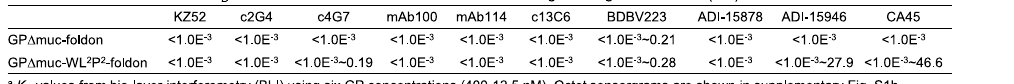
Fig. 2 Design and characterization of EBOV GP Δ muc trimers with modi fi ed HR1 C bend. a Ribbon representation of EBOV GP Δ muc protomer (PDB: 5JQ3) in transparent molecular surface with GP1 in dodger blue, GP2 in yellow, and HR1 C bends from three protomers in red. Left: side view. Right: top view. b Left: Ribbon representation of the HR1 region in the prefusion (top, PDB ID: 5JQ3) and postfusion (bottom, PDB ID: 2EBO) states with the HR1 region in yellow and the HR1 C bend in red. Right: Zoomed-in view of the HR1 C bend with the eight residues in this region shown as sticks and labeled with the proline mutations, P 1 -P 8 . c SEC pro fi les of mAb114-puri fi ed GP Δ muc-W615L-P n variants ( n = 1 – 8) from a Superdex 200 10/300 column. SEC pro fi les of mAb100- puri fi ed GP Δ muc-W615L-P 2 and -P 4 are shown in the red dotted line. Trimer (T), dimer (D), and monomer (M) peaks are labeled on the SEC pro fi les for P 2 and P 4 , with the trimer peak marked with a black dashed line. d BN-PAGE gel of mAb114-puri fi ed GP Δ muc-W615L-P n variants ( n = 1 – 8). e SEC pro fi les of 293F-expressed, mAb100-puri fi ed GP Δ muc-W615L-L-P 2 (or WL 2 P 2 )-foldon from a HiLoad Superdex 200 16/600 column (left) and BN-PAGE gel of SEC fractions 41 – 63 (55.5 – 62.0 ml) (right). SEC pro fi les were from three production runs. f Thermostability of GP Δ muc-WL 2 P 2 -foldon and GP Δ muc-WL 2 P 4 - foldon, with T m, Δ T 1/2 , and T on measured by DSC. g EC 50 ( μ g/ml) values of EBOV GP-foldon, GP Δ muc-foldon, GP Δ muc-W615L-foldon, GP Δ muc-WL 2 - foldon, and GP Δ muc-WL 2 P 2 -foldon binding to 10 representative antibodies. Four pan-ebolavirus NAbs are colored in red. Antibody binding was measured by ELISA in duplicates, with mean value and standard deviation (SD) shown as black and red lines, respectively. h K D values of GP Δ Muc-foldon and GP Δ muc-WL 2 P 2 -foldon binding to 10 representative antibodies. BLI was performed on an Octet RED96 instrument using a trimer titration series of six concentrations (400 – 12.5 nM by twofold dilution) and kinetics (AHC) biosensors. The K D values were calculated using a global fi t 2:1 model. Source data are provided as a Source Data fi le.